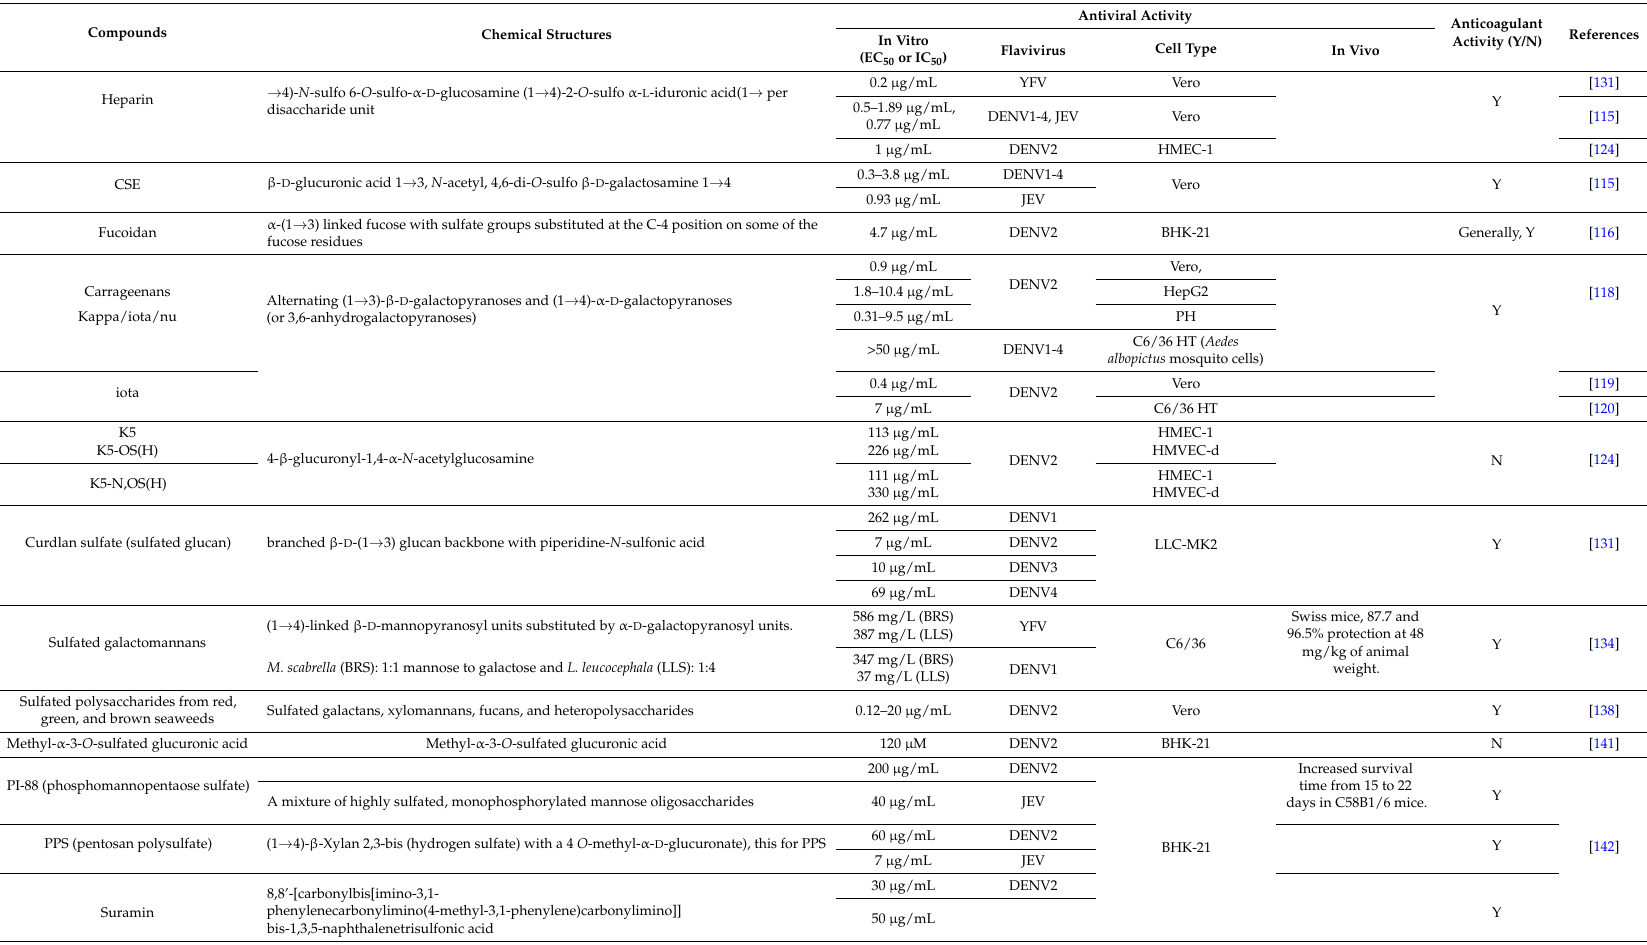
BHK-21: baby hamster kidney fibroblasts; BRS: Sulfated galactomannans from M. scabrella; CSE: chondroitin sulfate type E; DENV1-4: dengue virus serotypes 1-4; EC 50 : half maximal effective concentration; HepG2: human liver cancer cell line; HMEC-1: immotalized human dermal microvascular endothelial cell line; IC 50 : half maximal inhibitory concentration; JEV: Japanese encephalitis virus; LLS: Sulfated galactomannans from L. leucocephala; YFV: yellow fever